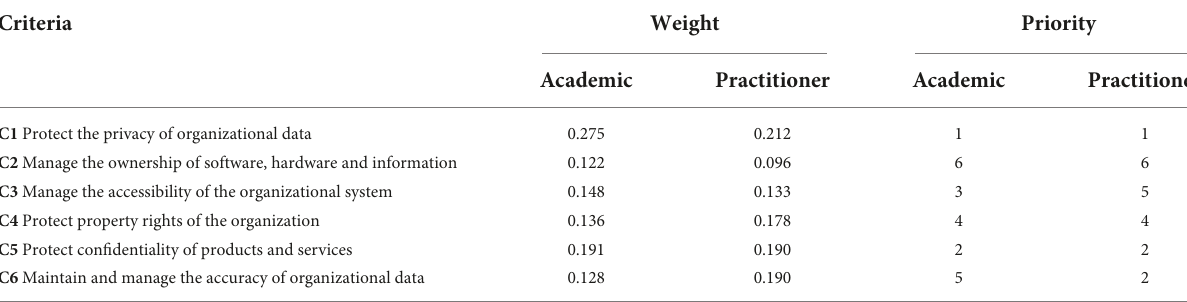
TABLE 11 Weights and ranking of organizational/workplace responsibilities criteria by LIS experts.